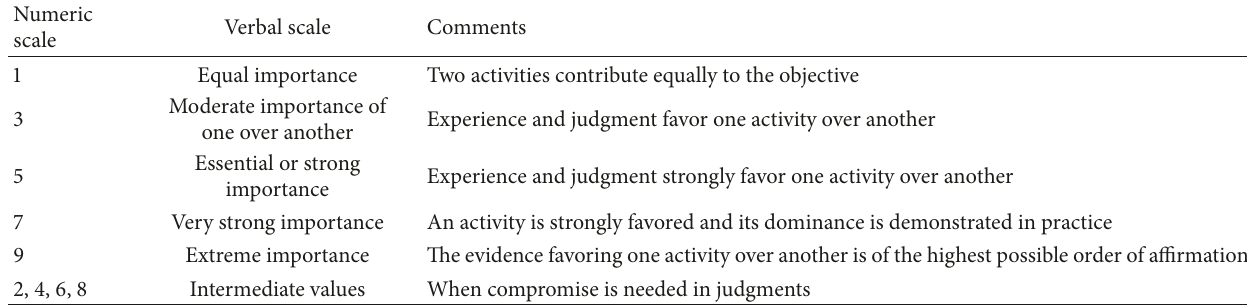
Table 1: AHP: the fundamental